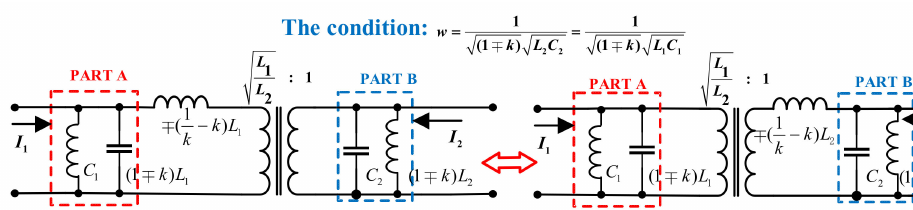
Figure 15. The equivalent model of the II_CC_CC circuit.